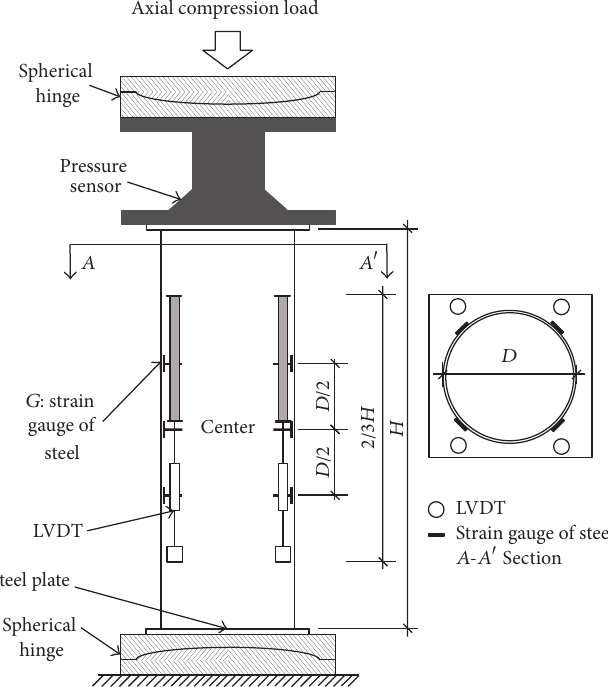
Figure 1: Test loading device and arrangement of measuring points.